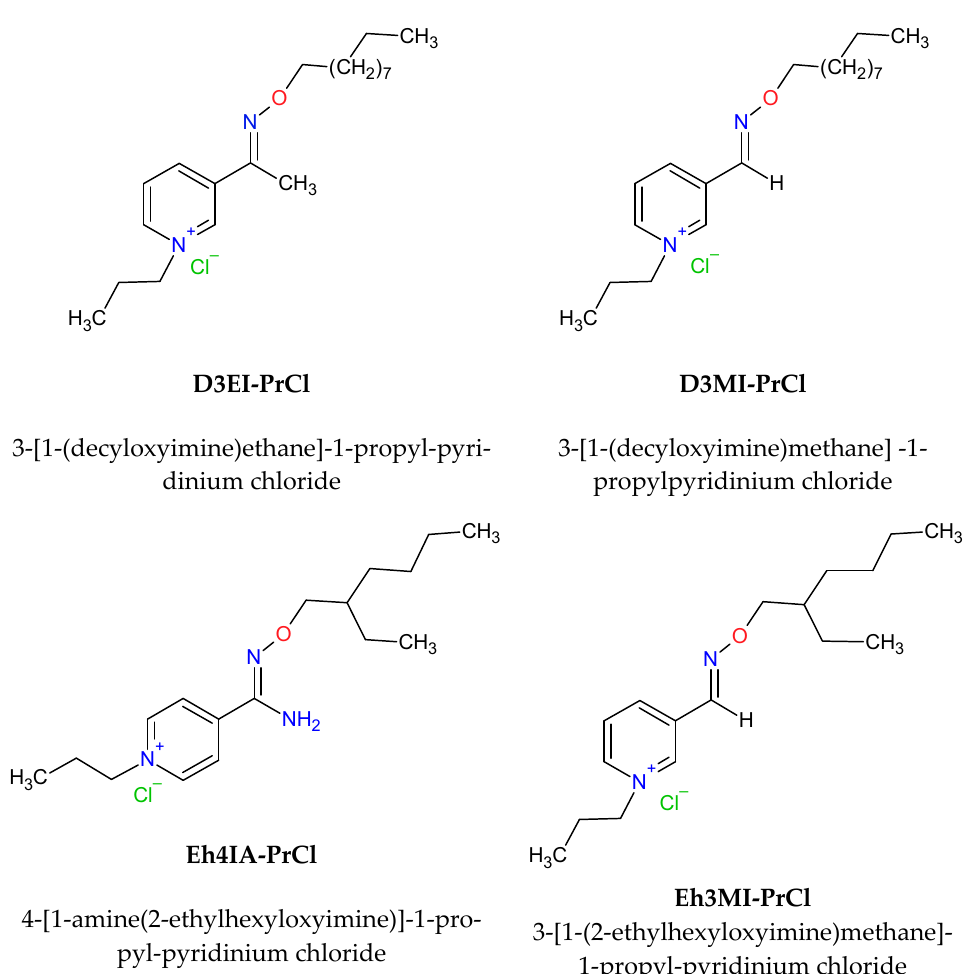
Figure 1. Structures of the quaternary pyridinium salts used as Pd(II) and Pt(IV) extractants.